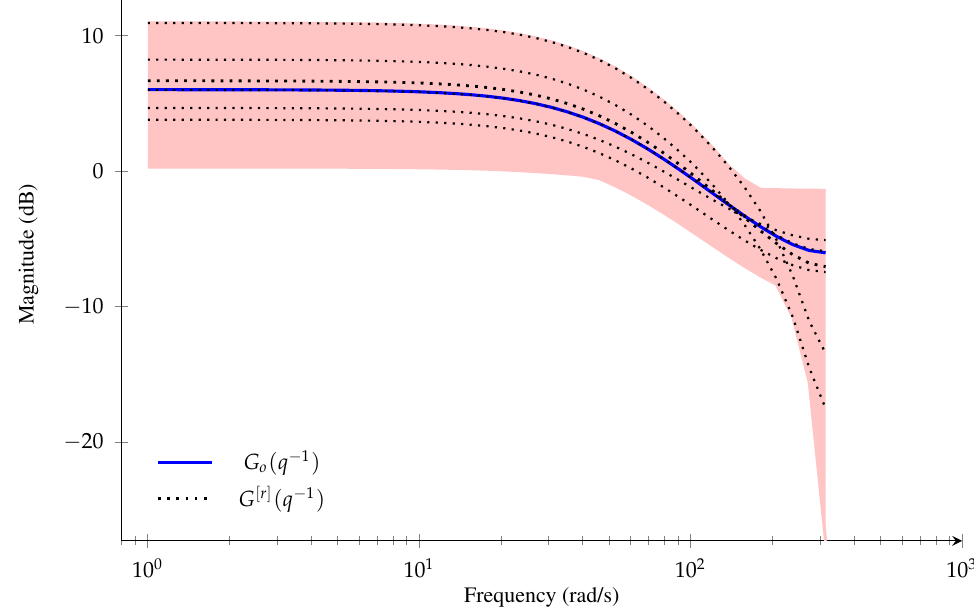
Figure 2. Magnitude of the frequency response for the linear dynamic system in Equation